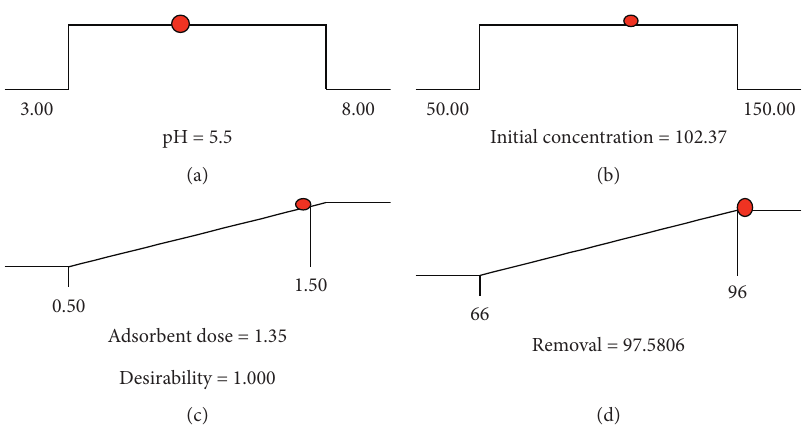
Figure 5: Desirability ramp for numerical optimization of four goals, namely, the solution pH (a), initial Pb (II) ion concentration (b), adsorbent dose (c), and removal efficiency (d).